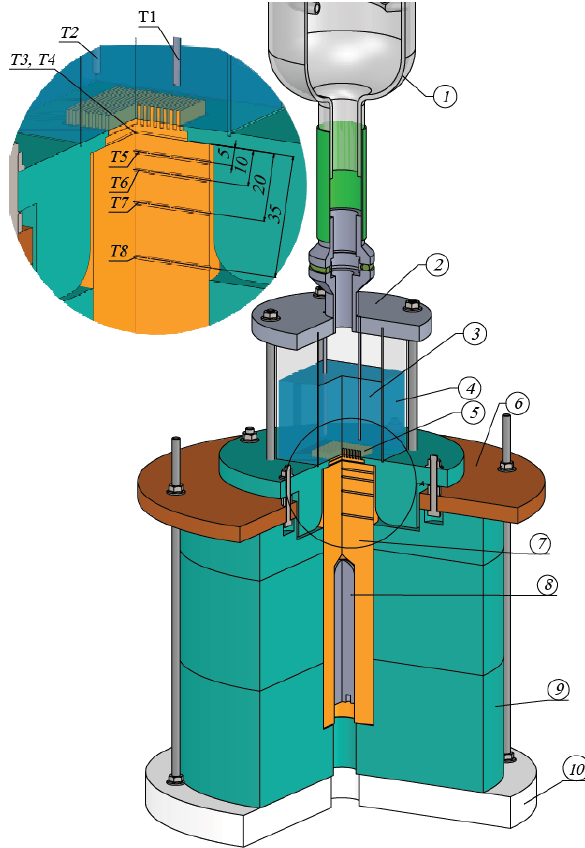
Fig. 2. Visualization of the main module of the test stand; 1 – condenser, 2 – top flange, 3 – boiling liquid, 4 – glass vessel, 5 – specimen, 6 – annular flange, 7 – copper cylinder, 8 – cartage heater, 9 – insulation, 10 – bottom flange. Dimensions in millimeters.